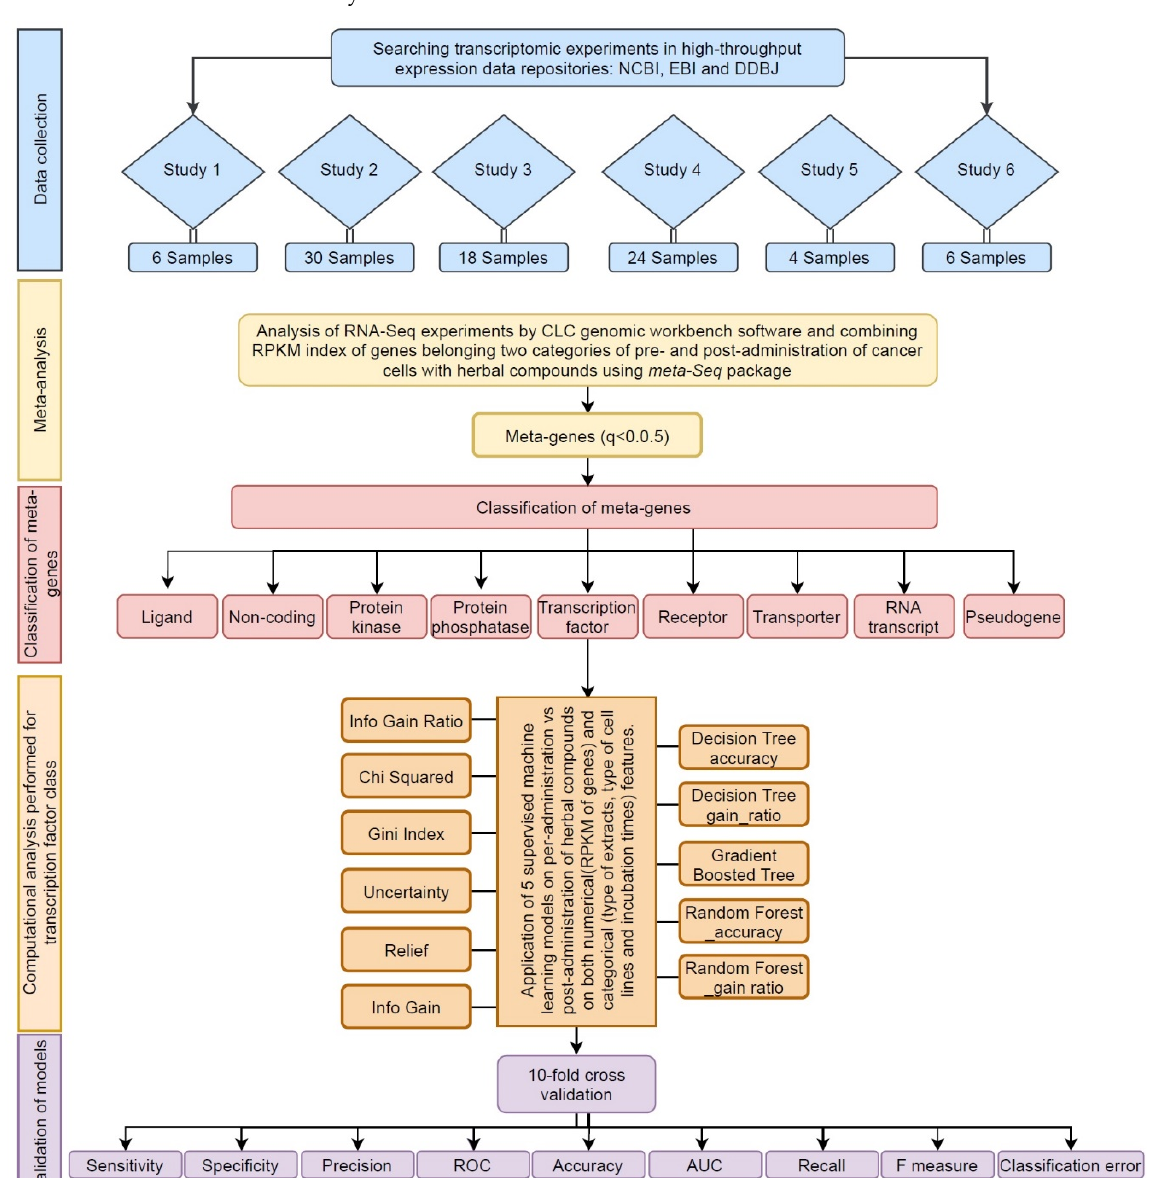
Figure 1. The flowchart of computational systems biological approach, developed in this study. This system’s biological approach includes 5 steps: data collection (blue), meta-analysis (yellow), meta-gene classification (red), pattern discovery (orange), and validation of model (purple).